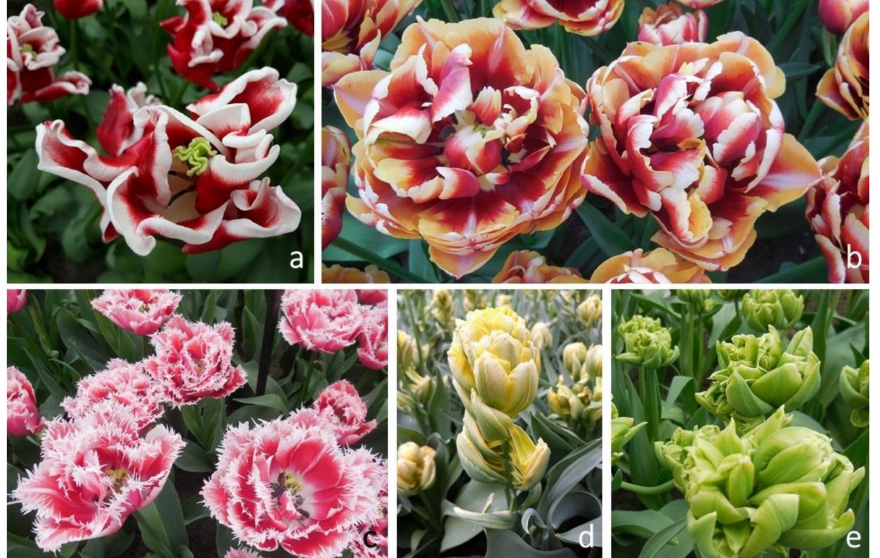
Figure 6. Novelties of Tulipa cultivars presented at the Keukenhof exhibition, the Netherlands, 2018: ( a ) cultivar ‘Elegant Crown’, an example of the new Coronet Group; ( b ) ‘Perfect Love’, from the Double Early Group; ( c ) ‘Brest’, a double fringed cultivar (officially registered in the Fringed Group); ( d ) cultivar ‘Artichoke’, with a new flower shape, officially registered as Viridiflora; ( e ) ‘Little Queen’, from the Double Early